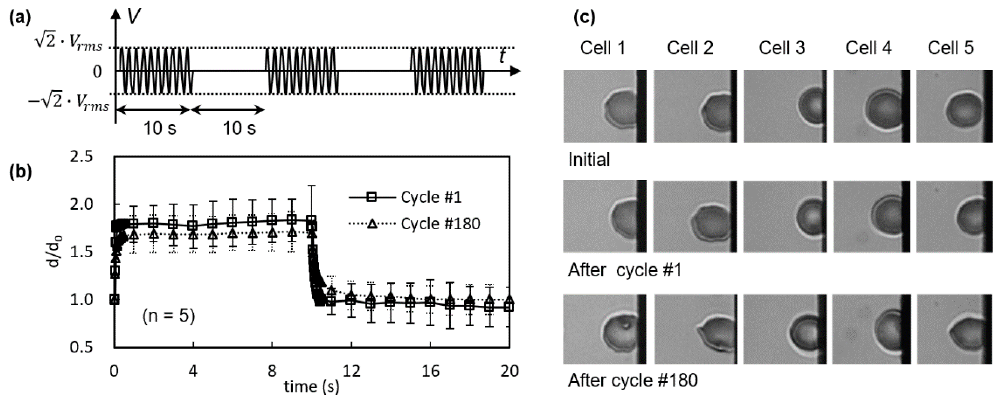
Figure 4. Electrodeformation of erythrocyte membranes during cyclic square waveforms. ( a ) Electrical excitation was supplied to the erythrocyte suspension, each cycle consists of a duration for 10 s and a relaxation for 10 s. V rms value is 2 V. ( b ) Displacement of erythrocyte membrane to the electrode edge as a function of time ( n = 5) during the 1st and 180th cycles, respectively. Error bar represents the standard deviation. ( c ) Morphological of cells before electrodeformation and after the 1st and 180th cycles of electrodeformation.